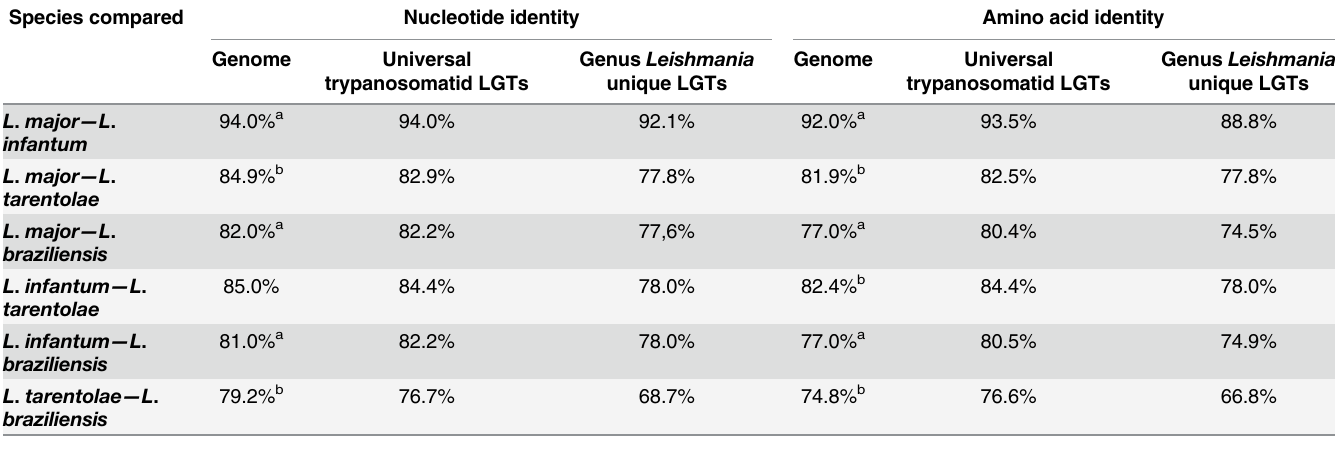
Table 2. Nucleotide and amino acid identity comparisons.